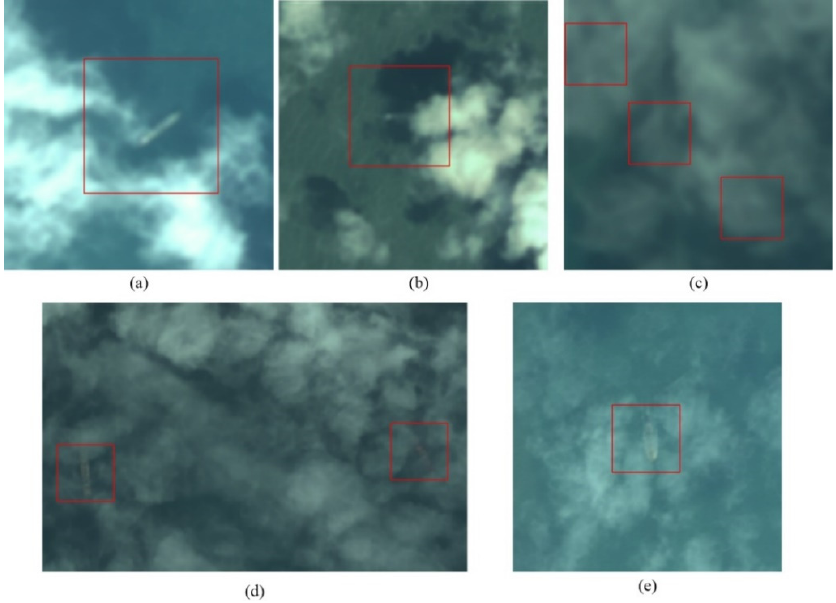
Figure 10. Detailed views of ( a – e ) of Figure 9. Enlarging the image can clearly see that the target blocked by the cloud has been detected.